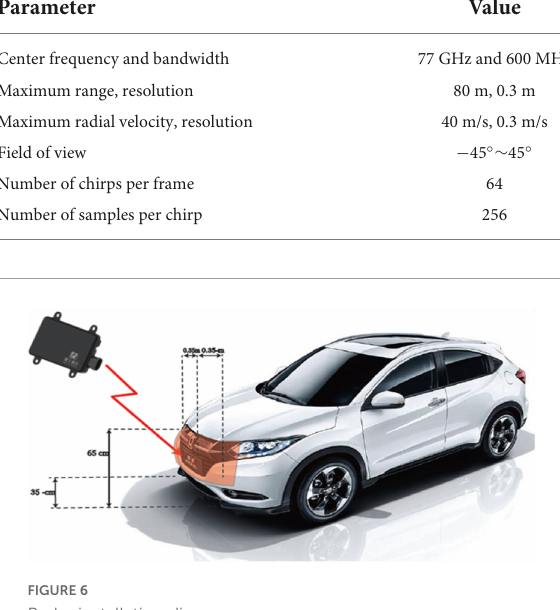
FIGURE6 Radar installation